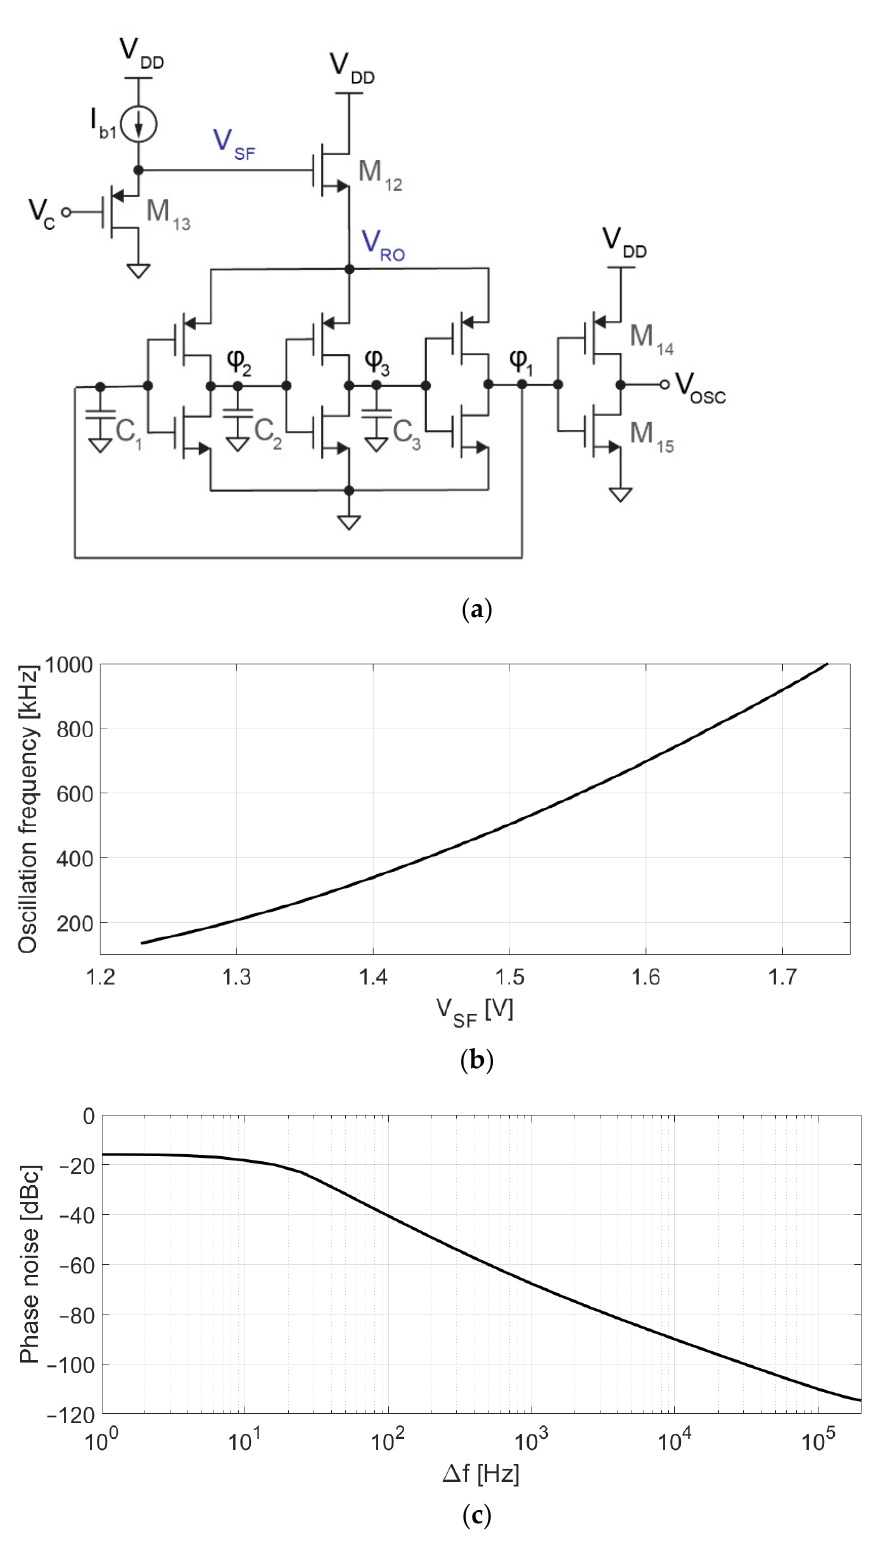
Figure 5. Voltage-controlled oscillator. ( a ) Schematic of the VCO, consisting of a 3-stage ring oscillator, a level shifter (M 14 –M 15 ), a source follower driving the ring oscillator (M 12 ), and a second source follower (M 13 ) for adapting the DC voltage level from V C (0.9 V) to V SF (1.5 V); ( b ) Simulated voltage-to-frequency response; ( c ) Simulated phase noise.